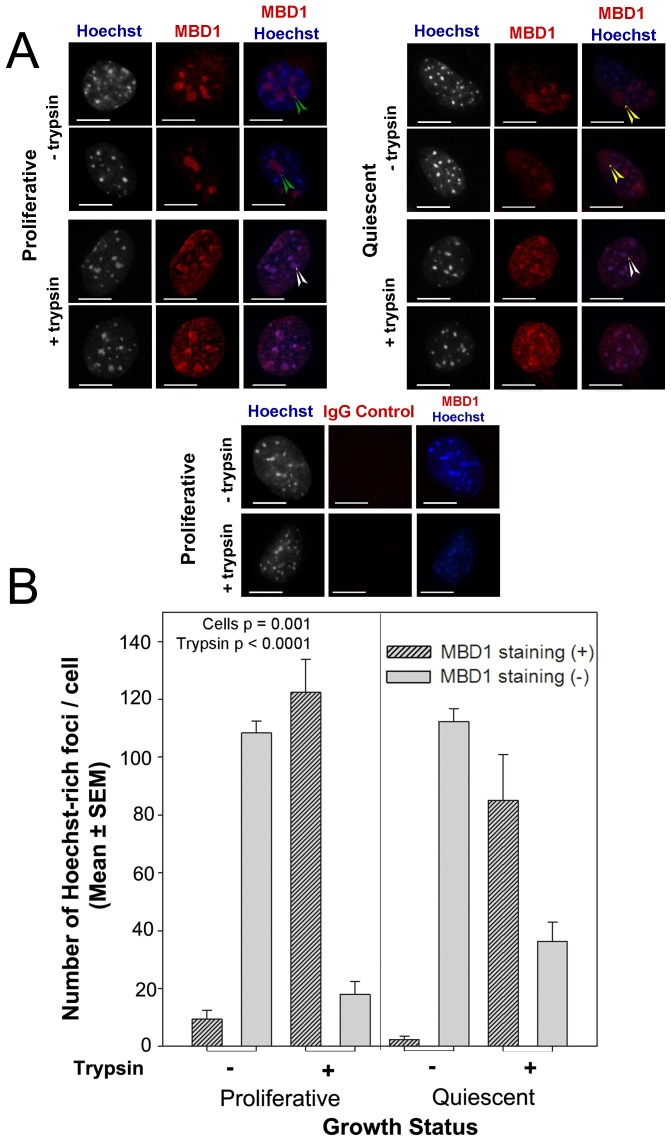
The effect of growth on the pattern of co-staining for MBD1 and bisBenzimide (Hoechst).
A Co-staining of MBD1 (or non-immune IgG control) and DNA stain by Hoechst in proliferative and quiescent cells. Green, yellow and white arrowheads represent different localized MBD1 foci than Hoechst-rich foci. Scale bar 10 µm. B The number of Hoechst-dense regions showing coincident staining with MBD1 (+) or not (−). Cell growth (p = 0.001) affected this coincident staining and trypsin use (p<0.0001) affected this detection. The results are of three independent replicates.